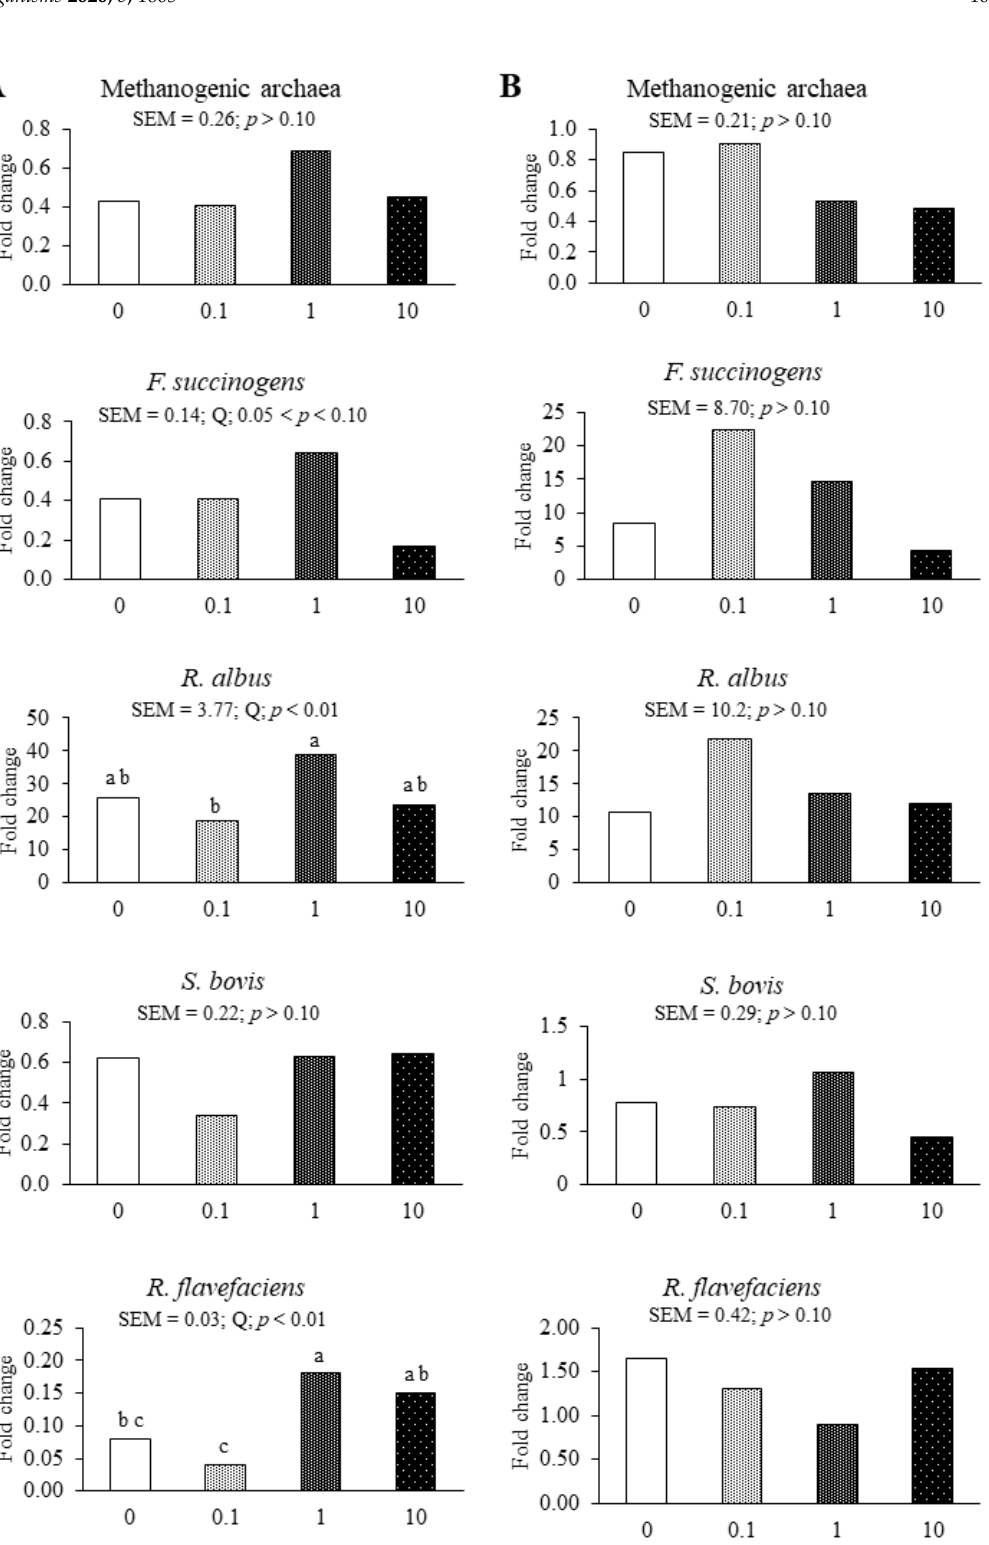
Figure 2. Effects of applying essentials oil from San wormwood at increasing levels to SBM ( A ) or BGH ( B ) substrates on fold changes of rumen microbial populations compared to that of the blank after 72 h of in vitro incubation in buffered rumen fluid. The San essential oil was applied at 0, 0.1, 1, and 1 mg/kg per 40 mL of buffered rumen fluid. The p -value indicated the polynomial contrast analysis; L, Linear effect; Q, Quadratic effect; C, Cubic effect. a–c: Means for the same microbe with different letters differ significantly ( p < 0.05).